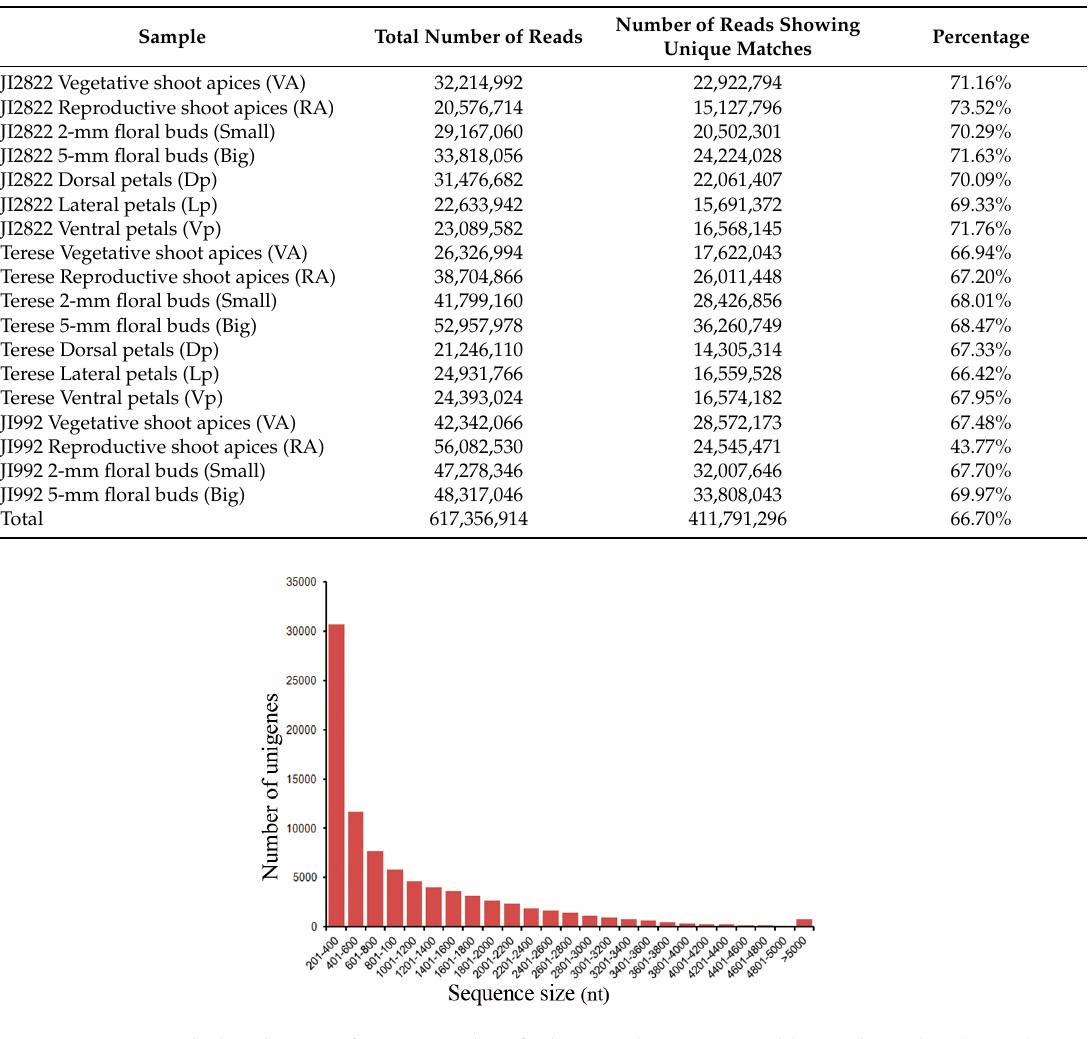
Table 1. RNAseq libraries analyzed in this study.